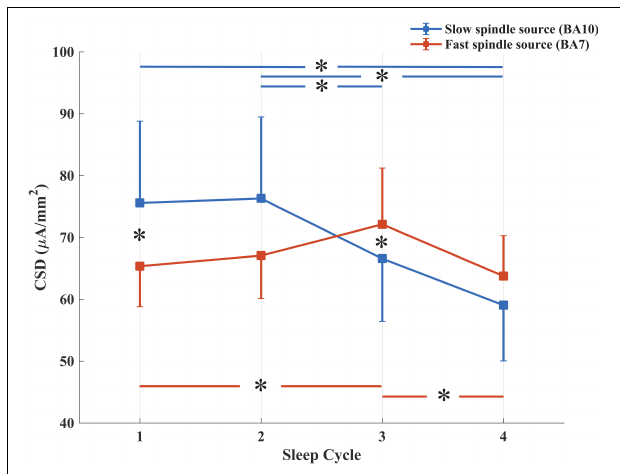
FIGURE 3 | Temporal evolution of mean CSD in BA10 (blue line) and BA7 (orange line) across NREM sleep cycles. ∗ Signficant at p < 0.05.